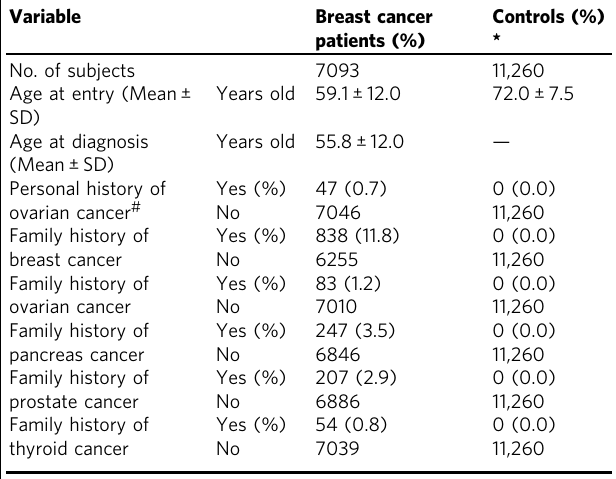
Table 1 Characteristics of study population in